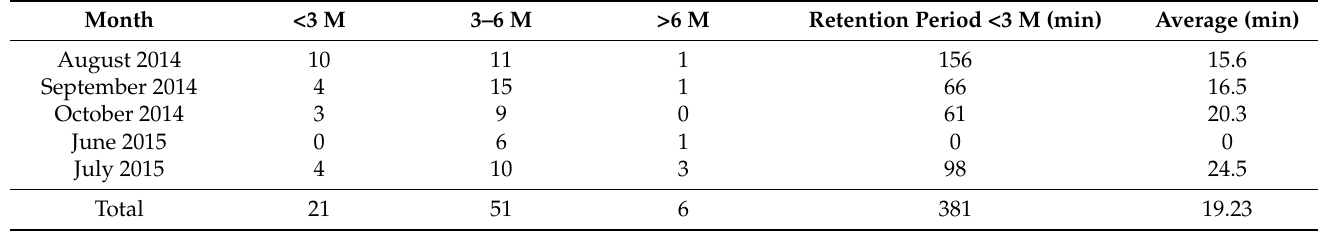
Table A4. Biševo island—density, distance and retention period of cruise ships’ traffic in selected high-risk navigational and environmental region.